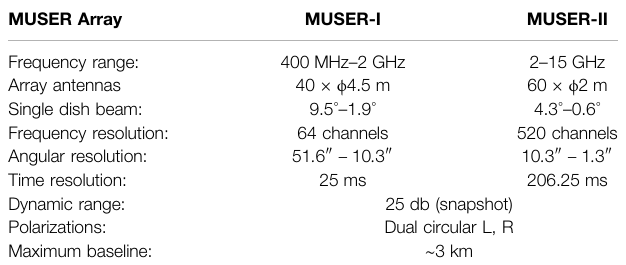
TABLE 1 | MUSER characterestics and performance. MUSER Array